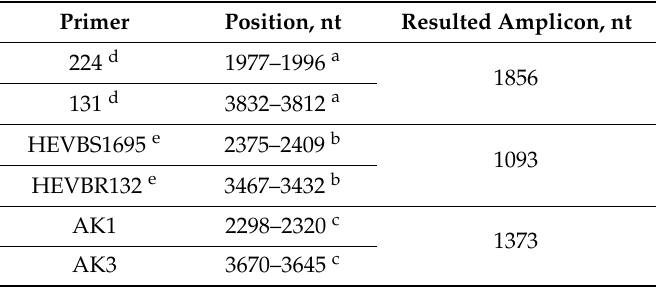
Table 1. Oligonucleotide primers used in this study and the resulted